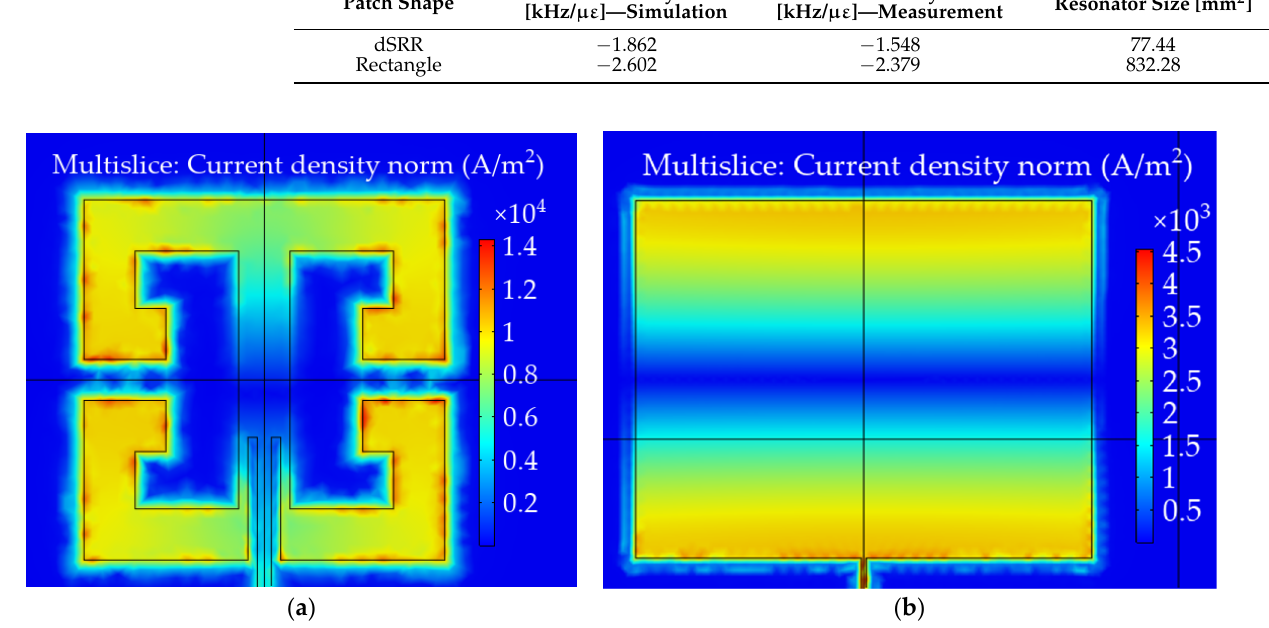
Figure 6. Current density [A/m 2 ] distribution in case of resonant frequency ( a ) dSRR microstrip sensor; ( b ) rectangular microstrip sensor.